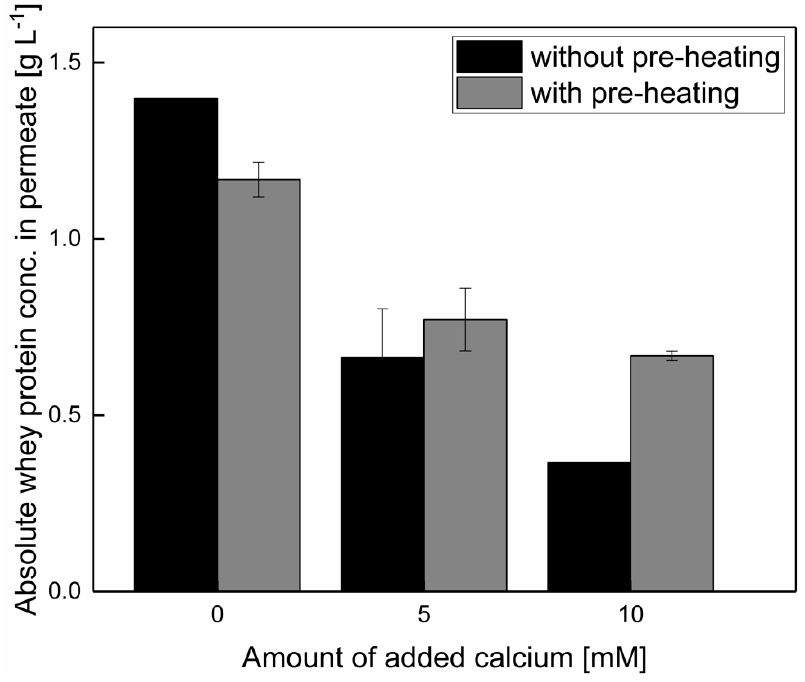
Figure 4. Whey protein concentration in the MF permeate after the addition of 0, 5, and 10 mM calcium. 10 mM